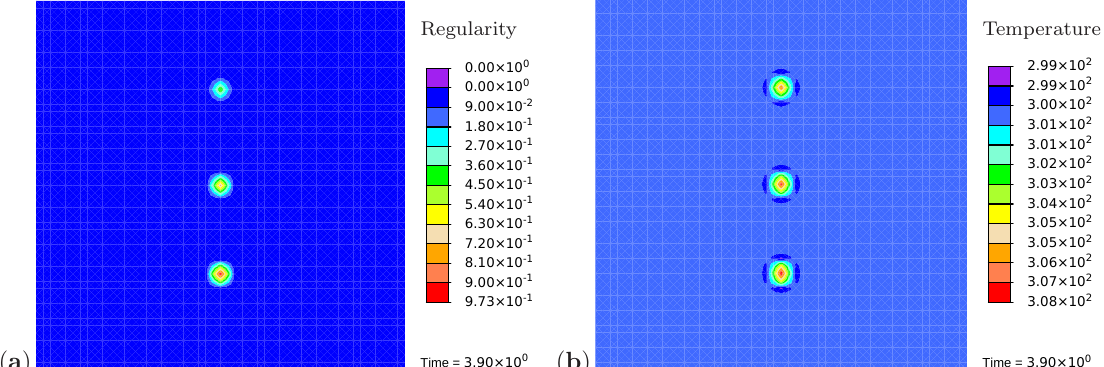
Figure 6. Simulation of the cyclic tensile test for a sample with three nuclei. Snapshots of the microstructure evolution during the loading stage (¯ λ = 4.9) showing ( a ) regularity distribution and ( b ) temperature distribution (in Kelvin).